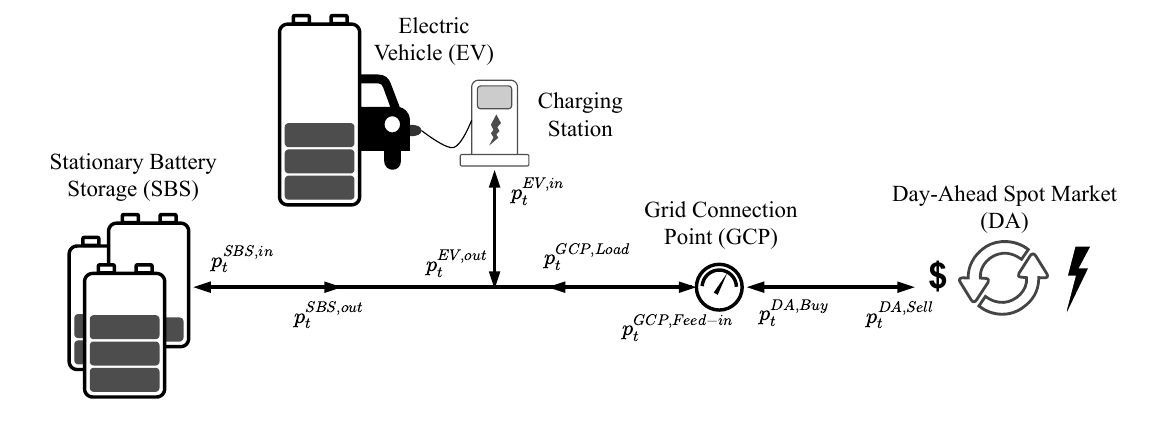
Figure 2. Flexible components and associated power